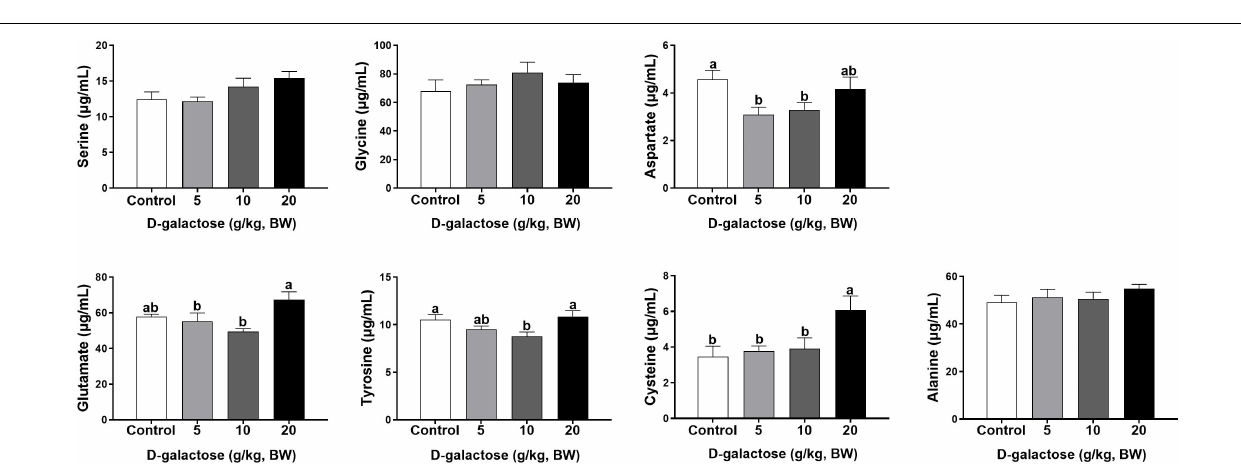
FIGURE 5 | Effects of D -galactose on non-essential amino acids in the serum at the first week. Data were expressed as the mean ± SEM. Different lower-case letters indicate a significant difference among different dosage of D -galactose ( P <